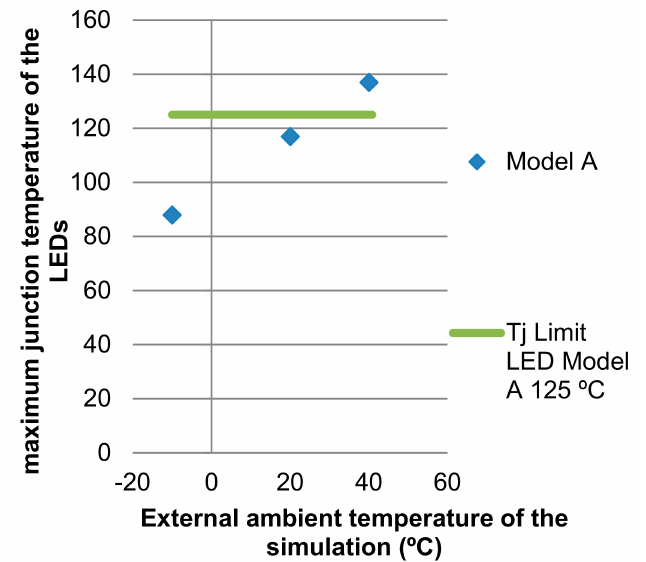
Figure 24. Variation of the maximum junction temperature of the LEDs with respect to the ambient temperature of the simulation, marking the limit junction temperature of each LED. Source: our own